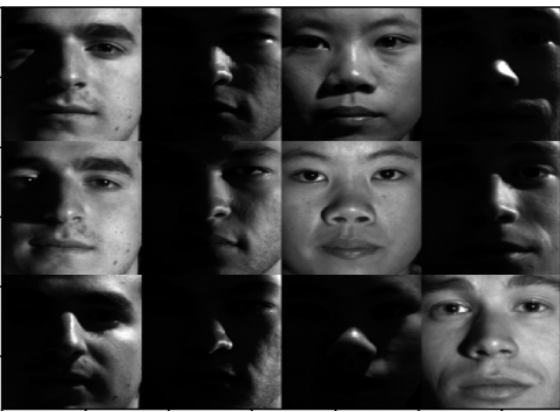
Figure 12. Some face images from Extended Yale B [ Reprinted with permission from Elsevier [20]. Copyright 2013, Neurocomputing ] .